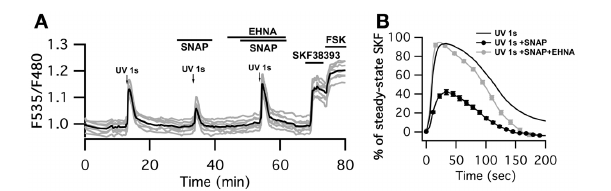
FIGURE 5 | SNAP inhibits the PKA response to brief (1s) dopamine uncaging in D 1 MSNs. (A) MSNs expressing AKAR3 were imaged in wide-field microscopy to measure the PKA response to dopamine. Arrows indicate the UV flash. Flash photolysis of caged dopamine (NPEC-dopamine, 5 µ M in the bath) induced a transient ratio increase. SNAP decreased this response, and the PDE2 inhibitor EHNA (10 µ M) restored the response to caged dopamine to its initial level. (B) Mean responses in D 1 to 1s UV flash alone ( n = 84), in the presence of SNAP ( n = 80) and SNAP + EHNA ( n = 74). For each flash, responses were normalized with respect to the steady-state response to SKF38393. Markers are plotted sparsely for clarity; error bars represent SD